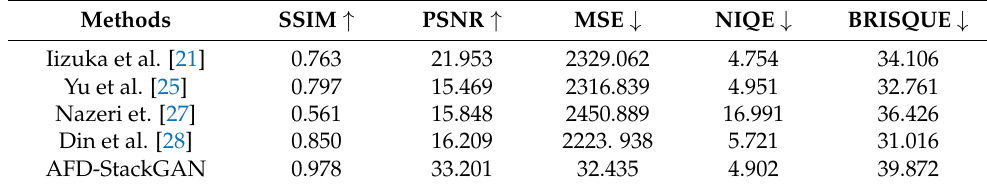
Table 2. Performance comparison of different methods in terms of SSIM, MSE, PSNR, NIQE, and BRISQUE. For PSNR and SSIM, higher values show superior performance, while for BRISQUE and NIQE, the lower, the better.